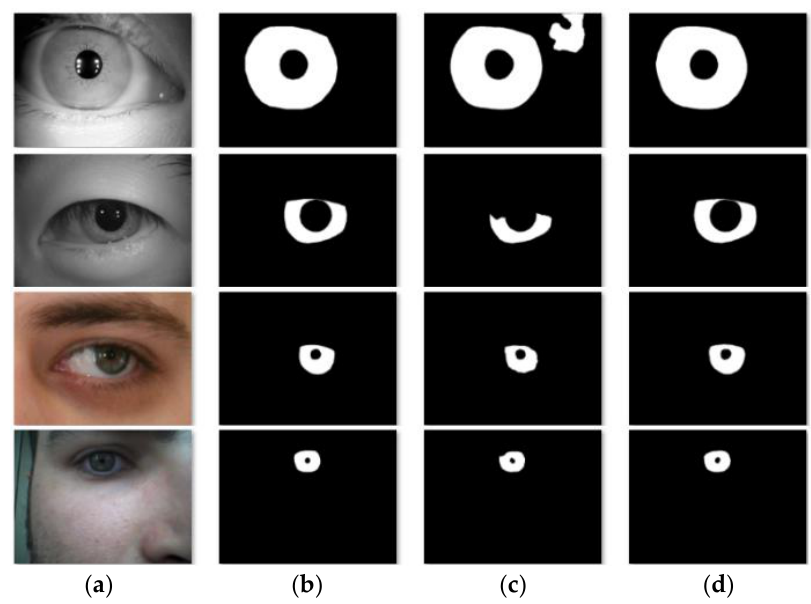
Figure 12. The segmentation results predicted by baseline and PFSegIris on four iris datasets: ( a ) original images; ( b ) ground truth; ( c ) segmentation results of baseline; ( d ) segmentation results of PFSegIris.